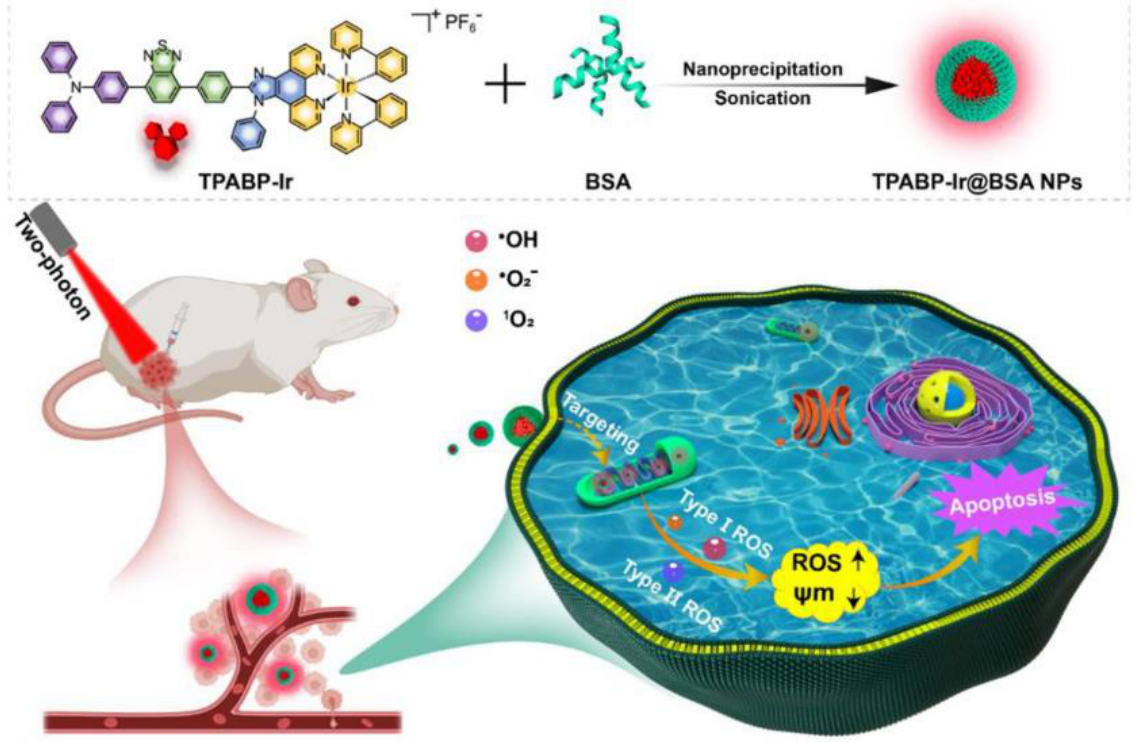
Figure 23. Schematic illustration of TPABP-Ir@BSA NPs for PDT treatment. Reprinted with permis- sion from Ref. [156]. Copyright 2022 Elsevier Ltd.